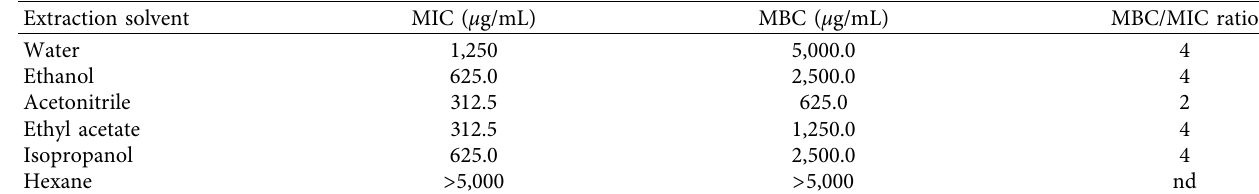
Table 3: MIC and MBC of A. lakoocha roxb extracts against MRSA.